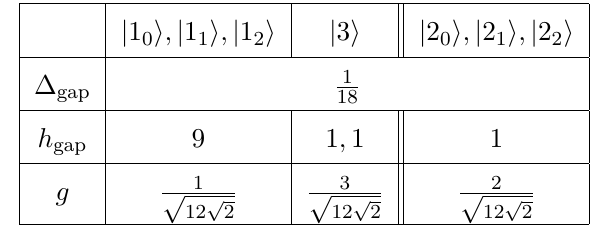
Table 3. Stable rational branes in the SU(2) 1 /A 4 orbifold CFT. They correspond to irreducible linear (left) and projective (right) representations of A 4 . The label | r i i keeps track of the multiple inequivalent r -dimensional representations of G . For each stable brane, we list the lowest scaling dimensions of the boundary operators, keeping track of their multiplicities.